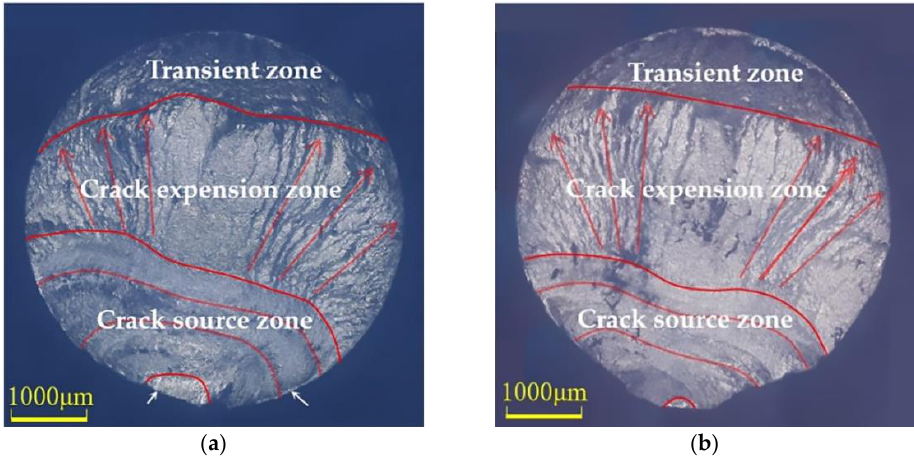
Figure 19. Fracture morphology of 6063-aluminum alloy samples with different powers. ( a ) The third set of test pieces, test power = 45%; ( b ) the eighth set of test pieces, test power = 60%.